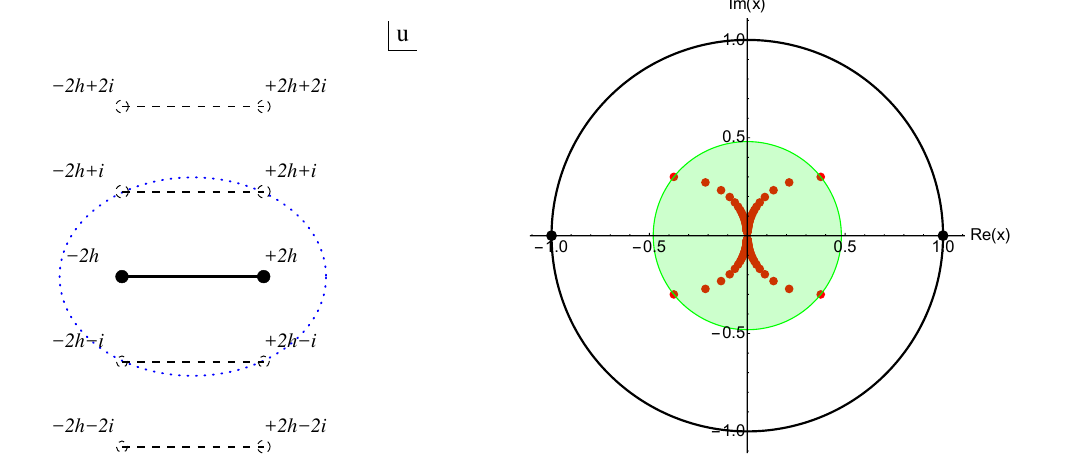
Figure 2 . Analytic structure of the P func- tions in the u -plane. The dotted ellipse de- limits the convergence region of the power expansions of P A in the second sheet of the u -plane.